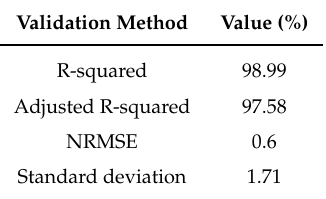
Table 4. Model validation.